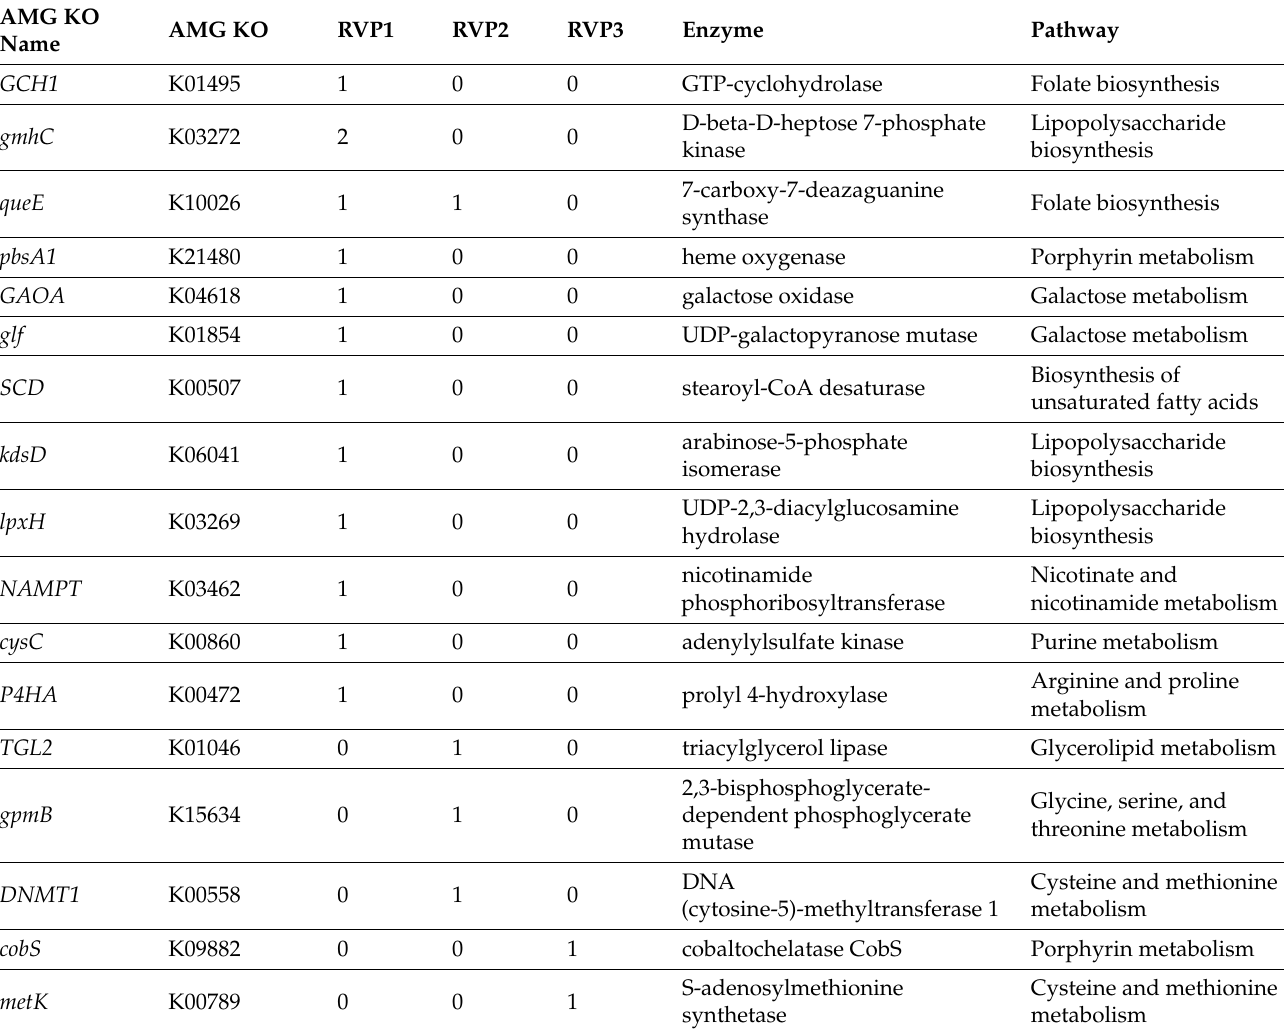
Table 2. AMG genes identified in metatranscriptomes of Lake